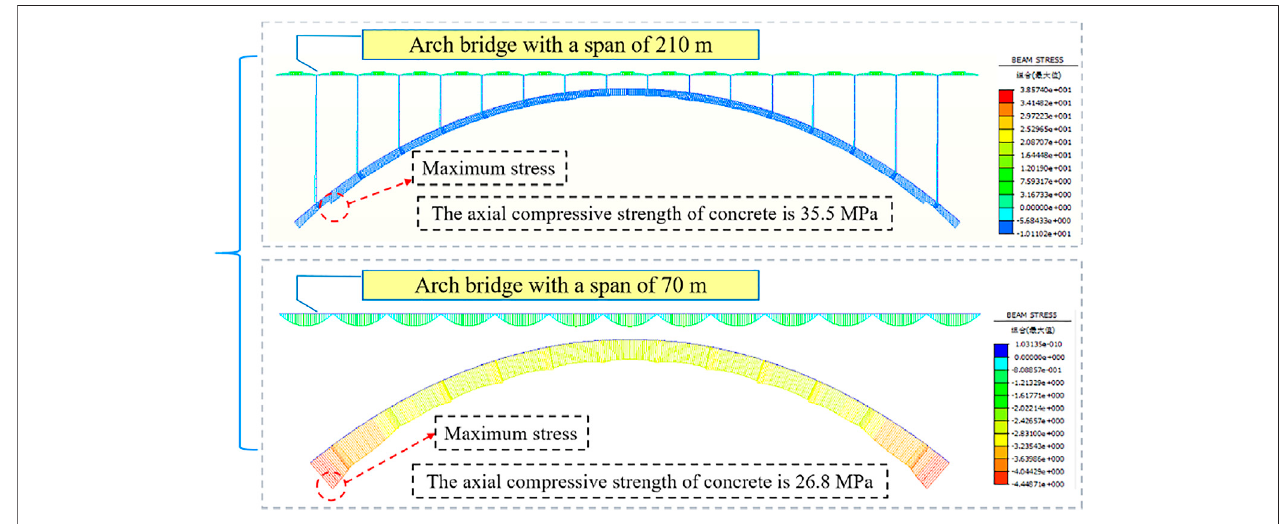
FIGURE 1 | Stress state of the real bridges under the dead load (MPa).